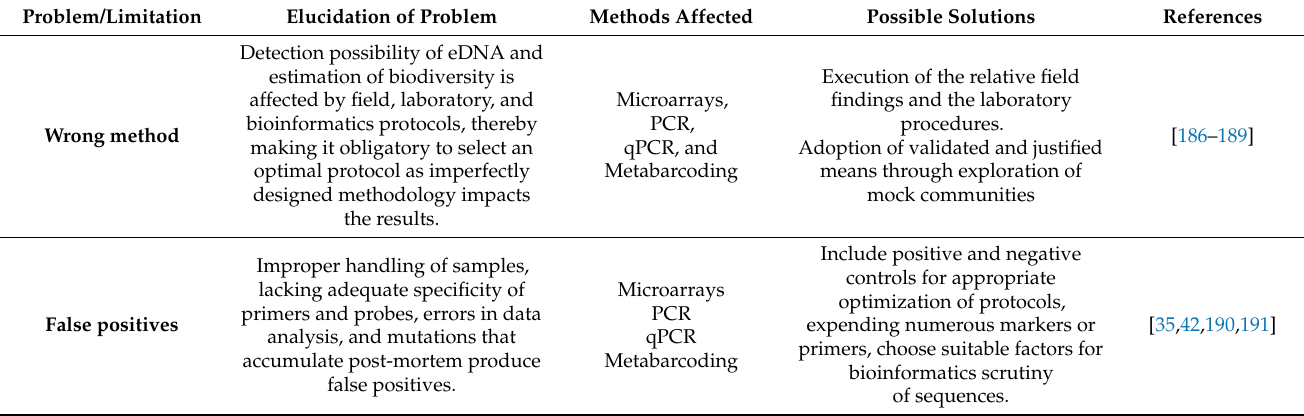
Table 5. Problems associated with eDNA-based species identification and potential possible